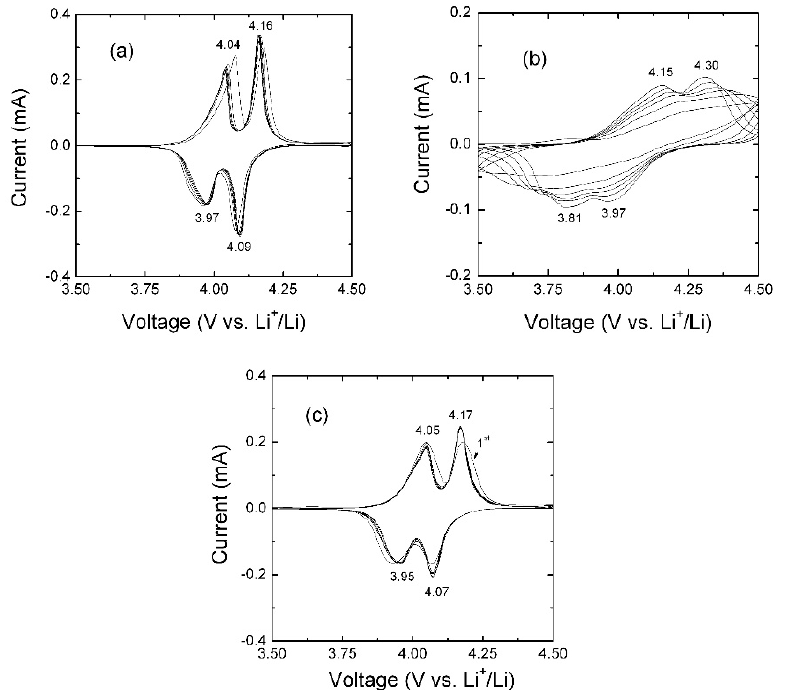
Figure 10. Cyclic voltammograms of samples cycled between 3.5 and 4.5 V ( vs. Li | Li + ) at a scan rate of 0.2 mV s − 1 : ( a ) pristine LMO; ( b ) Ag/LMO(a); and ( c ) Ag/LMO(v).